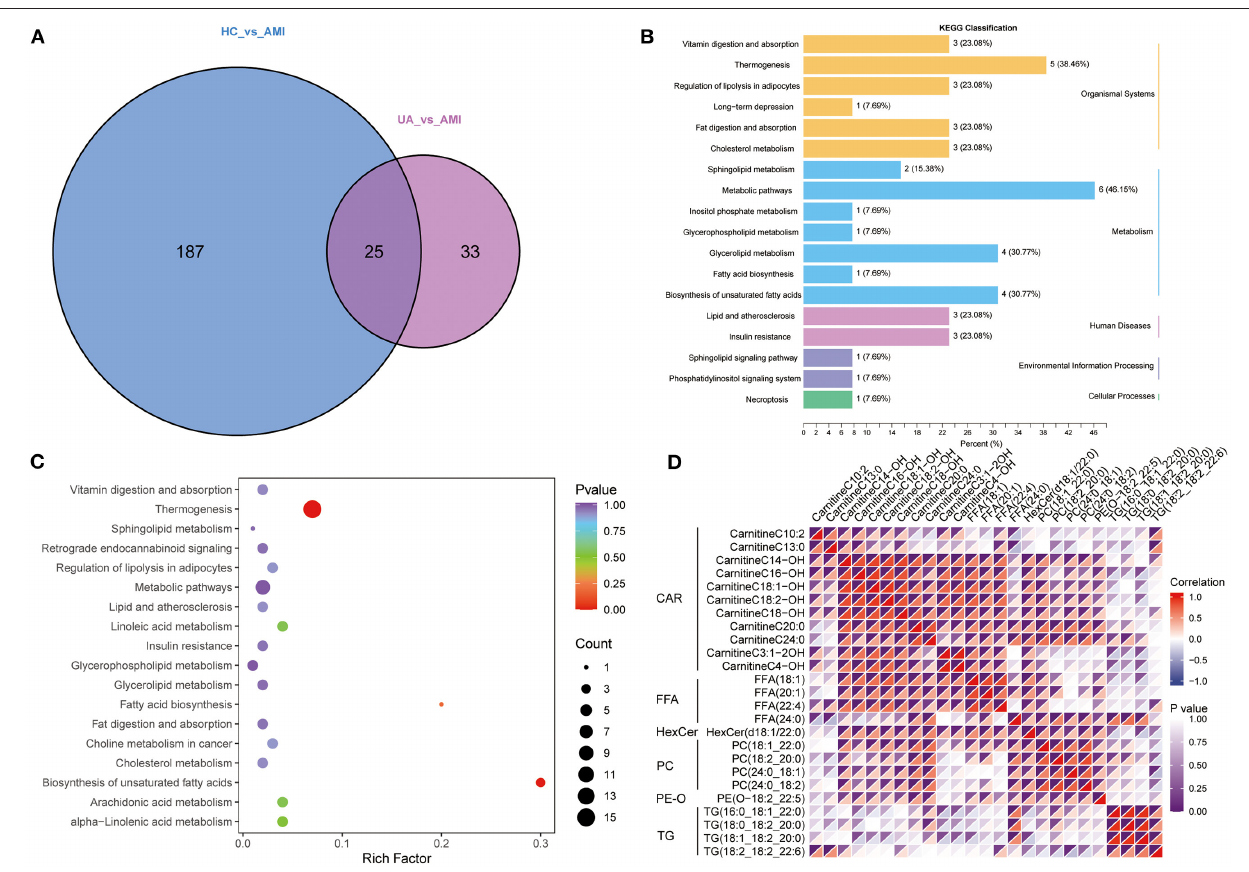
FIGURE 4 | Acquisition of common differential lipid metabolites. (A) . Venn diagram shows the common differential lipid metabolites between the group. (B) . The annotation results are classified according to the type of KEGG pathway. (C) . KEGG pathway enrichment analysis for common differential lipid metabolites. (D) . A cluster analysis of common differential lipid